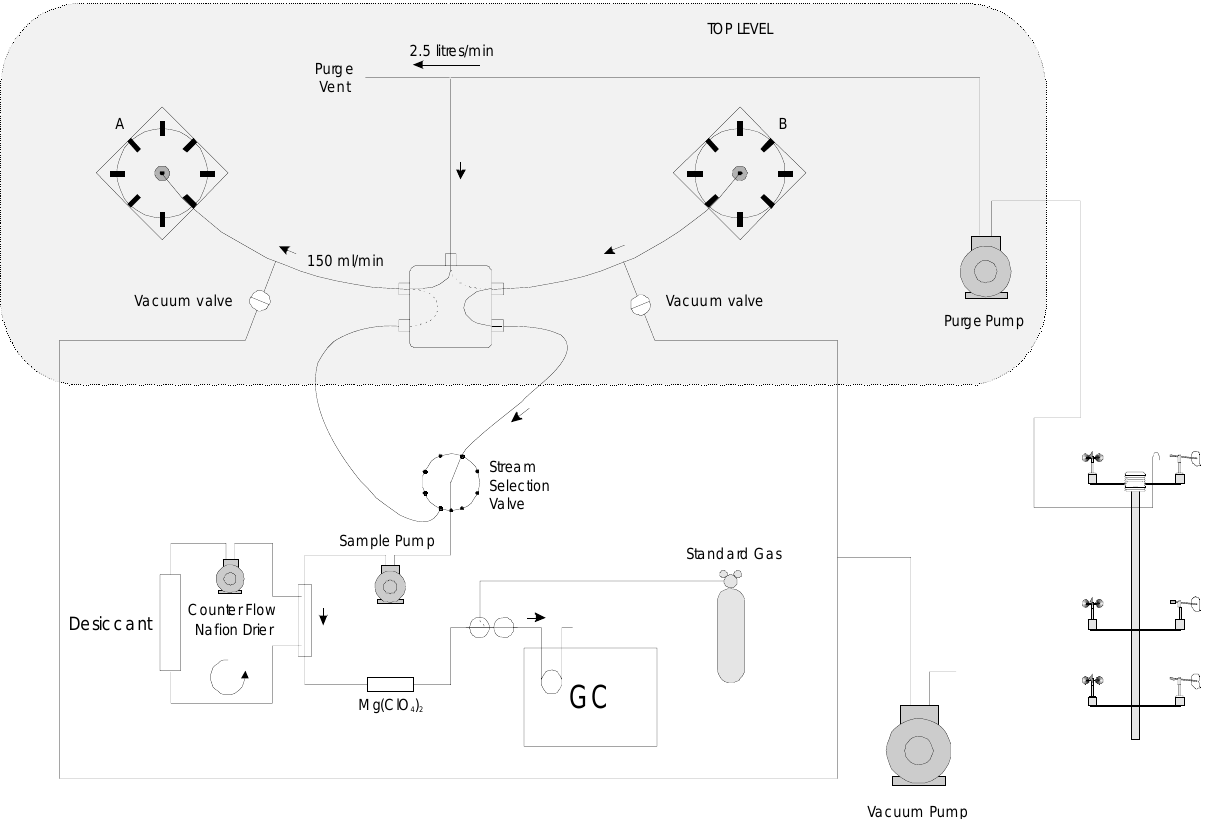
Fig. 1. A schematic of the Lung-GC system interfacing up to three inlets (shown as one sampling point on a micrometeorological mast). A purge pump for each airline maintains the flow between the sample inlets and the laboratory. In practice, sample inlets can be up to 200m away from the laboratory. While Cluster A is being filled, a sample is drawn from Cluster B, dried, and directed to the GC. When all the bags in Cluster B have been analysed they are evacuated and the cluster roles are reversed. Three 5 port valves (one per layer), one of which is depicted near the centre of the figure, switch simultaneously to control the role